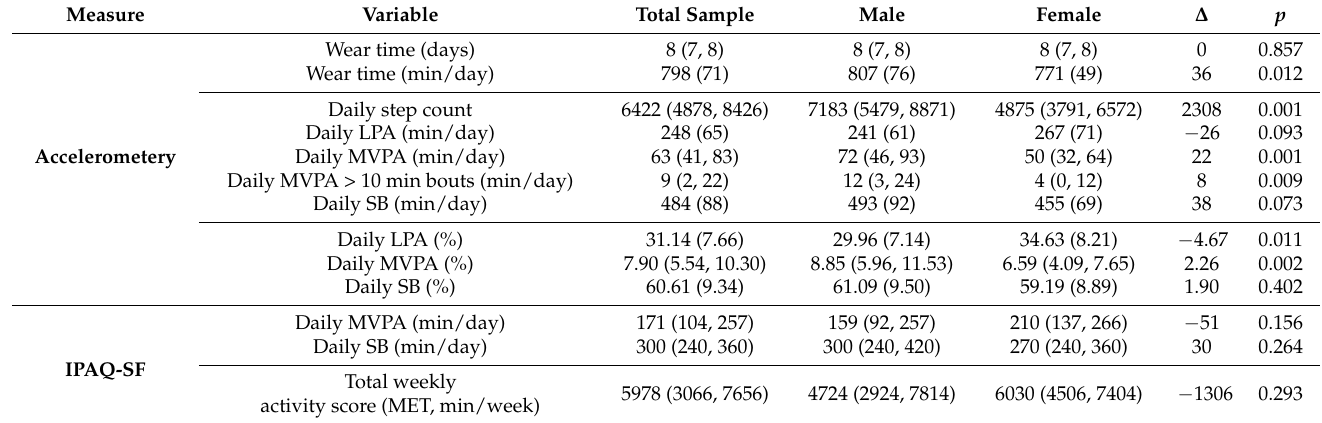
Table 2. Objectively and subjectively measured physical activity.